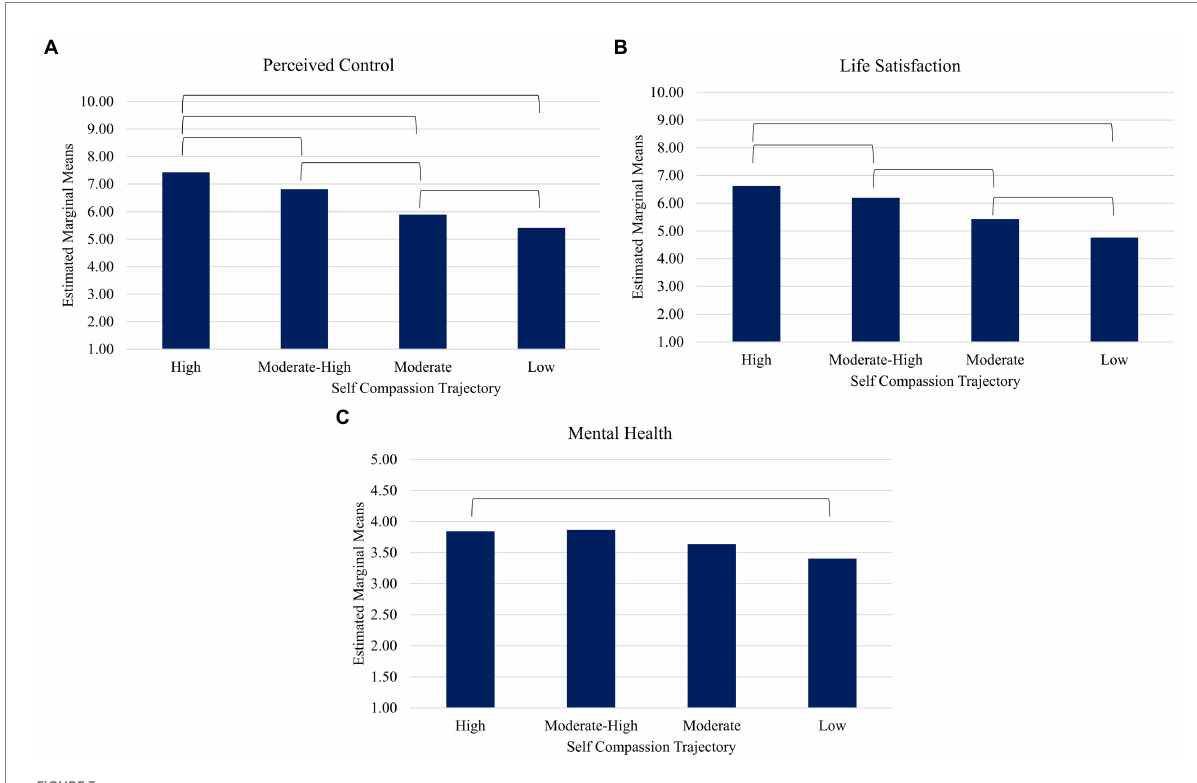
FIGURE 3 Main effects of self-compassion trajectory profile on wave 11 outcome variables of Perceived Control (A) , Life Satisfaction (B) , and Mental Health (C) .